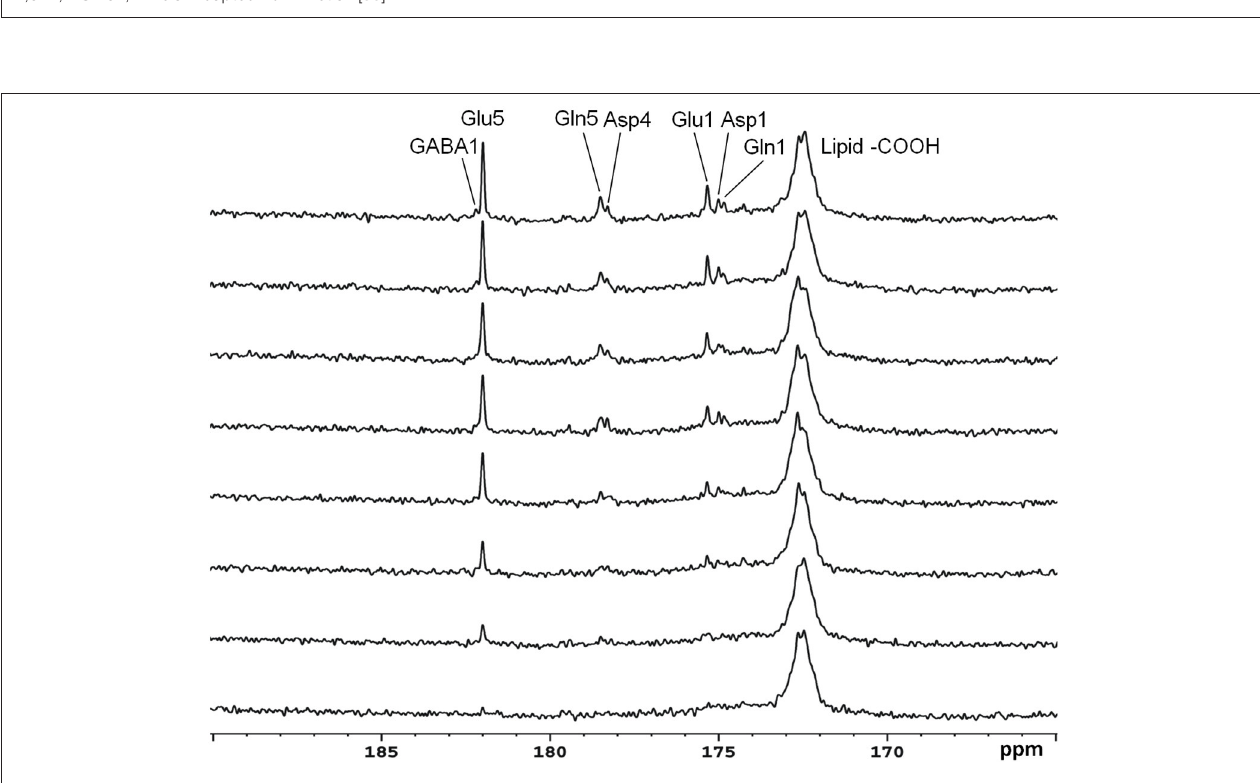
FIGURE 6 | Time course spectra of Glu, Gln, and Asp turnover detected in the occipital lobe during intravenous infusion of [2- 13 C] glucose at 7 Tesla. The decoupling power was 35 W and time-averaged decoupling power was 3.6 W. Each spectrum was averaged from an 8.7 min signal with NS 104, and TR 5s. Adapted from Li et al.